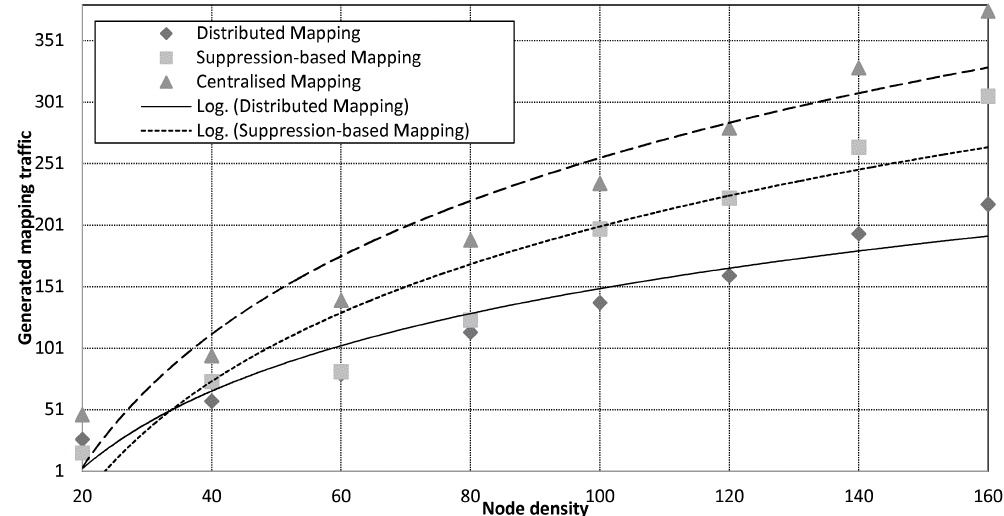
Figure 9. The cost of map generation against node